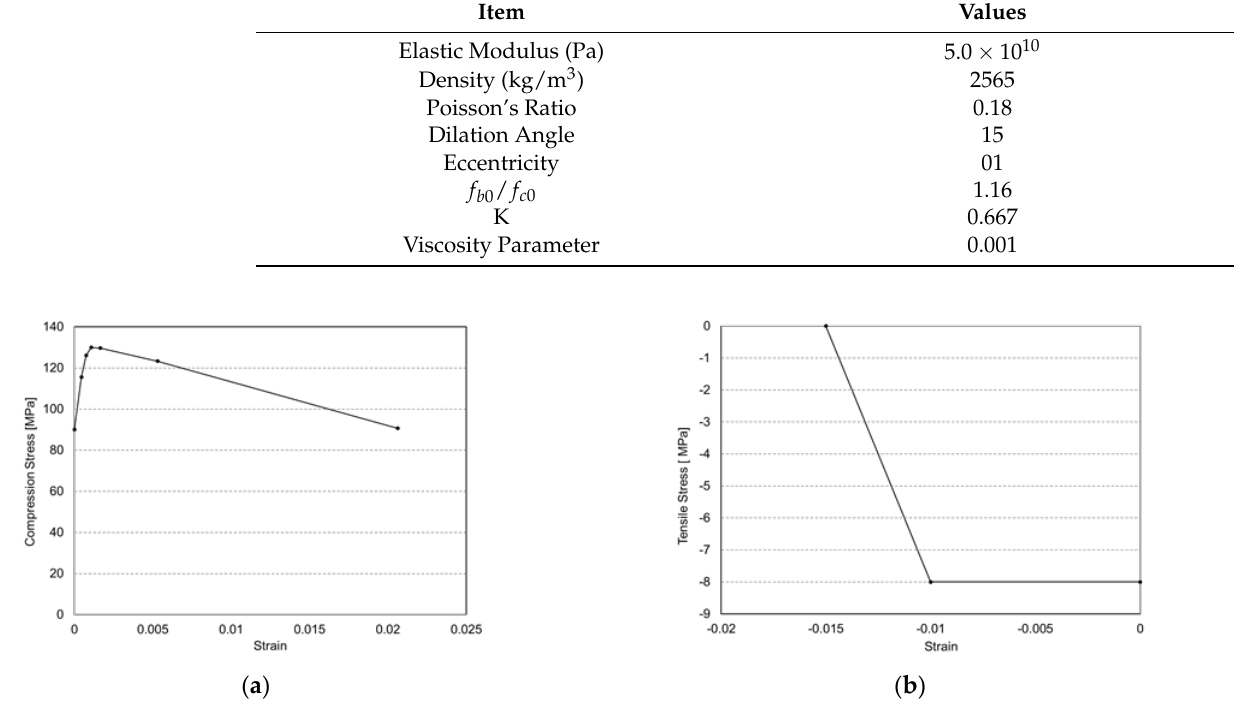
Figure 12. Behavior after UHPC linear elastic region for ( a ) compression behavior and ( b ) tensile